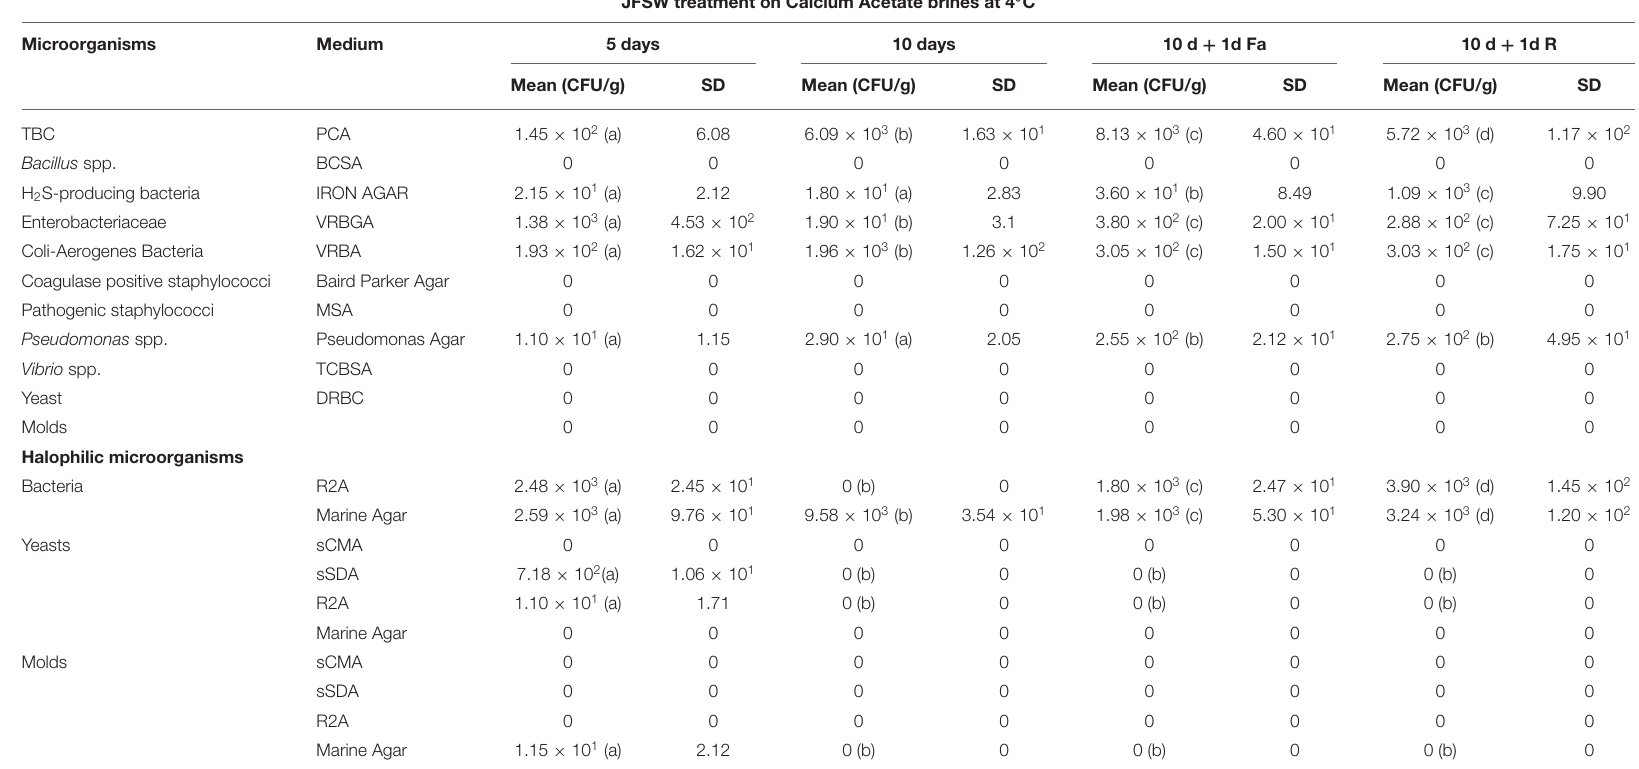
TABLE 2A | Microbiological analyses during time course treatment of JFSW with calcium acetate brines at 1, 5, and 10